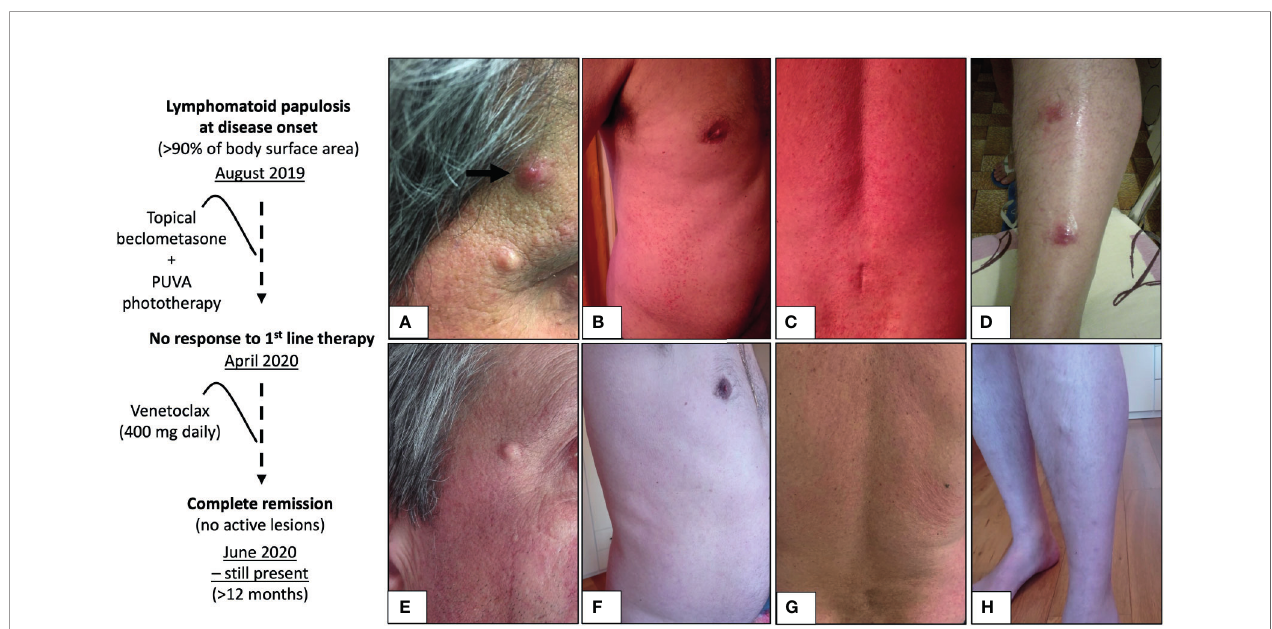
FIGURE 1 | Lymphomatoid papulosis at disease onset (A – D) and at 8 weeks from the initiation of venetoclax monotherapy (E – H) . Intensely pruritic red fl at-topped papules with diffuse erythema spreading on >90% body surface area (B, C) , accompanied with sparse nodules ( A , black arrow, and D ). At 8 weeks from the initiation of the potent selective BCL2 inhibitor venetoclax (400 mg daily), a complete response was achieved, as de fi ned by no detectable active skin lesions (E – H) , and it is still present (in May 2021), lasting more than 12